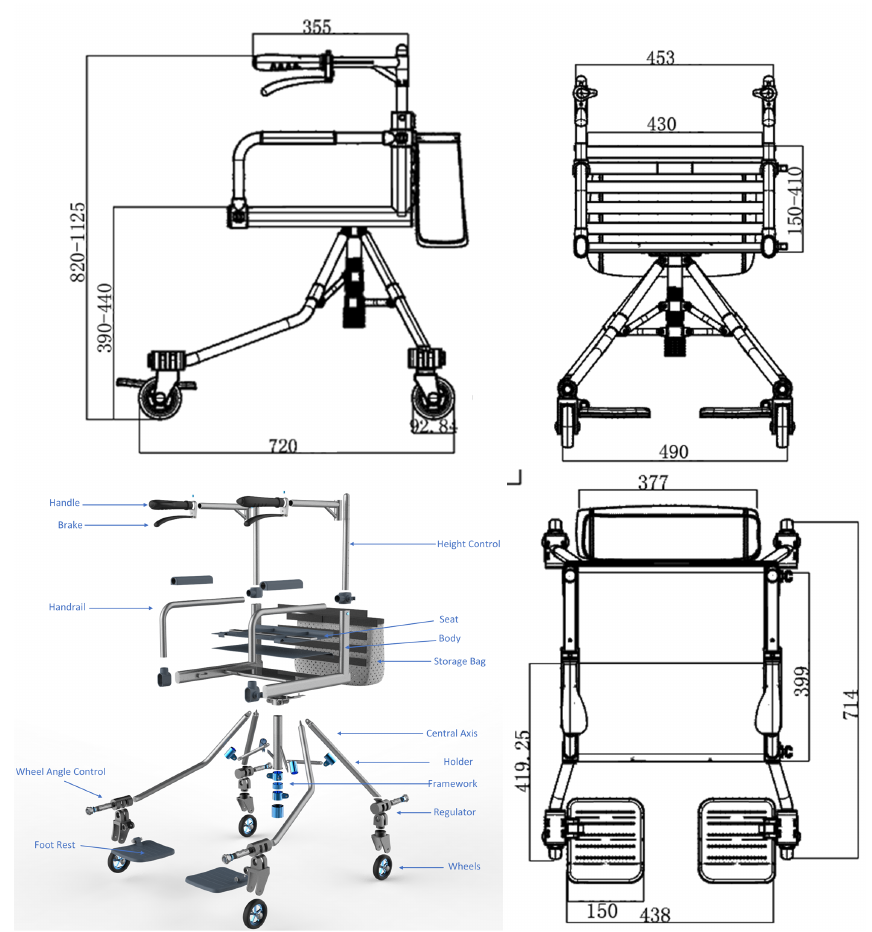
Figure 4. Novel designed four-wheeled rollator